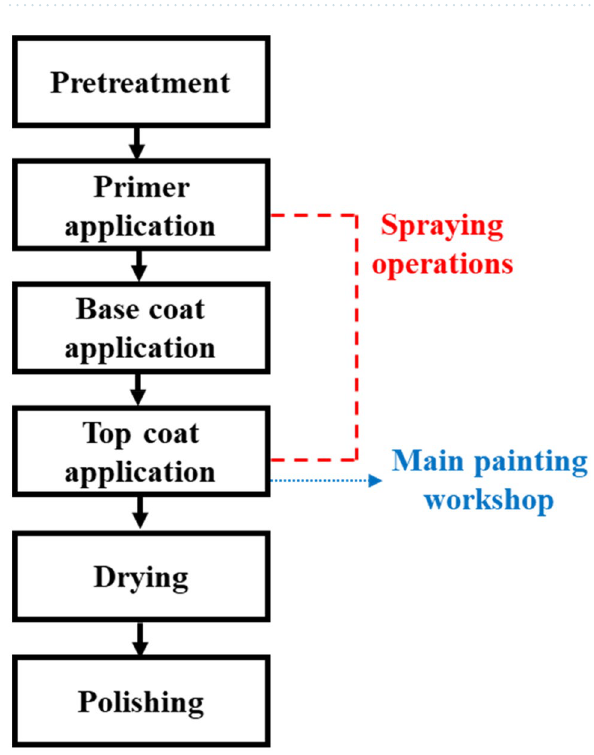
Figure 4. Illustration of an auto-repair painting workshop. ( a ) Illustration of a booth in an auto-repair painting workshop (Front view). ( b ) Illustration of an adsorption system connected to a booth (Top view).